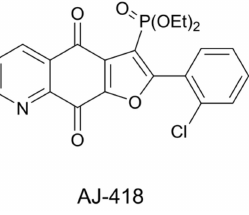
Figure 2. Structure of diethyl (2-(2-chlorophenyl)-4,9-dioxo-4,9-dihydrofuro[3,2- g ]quinolin-3- yl)phosphonate ( AJ-418